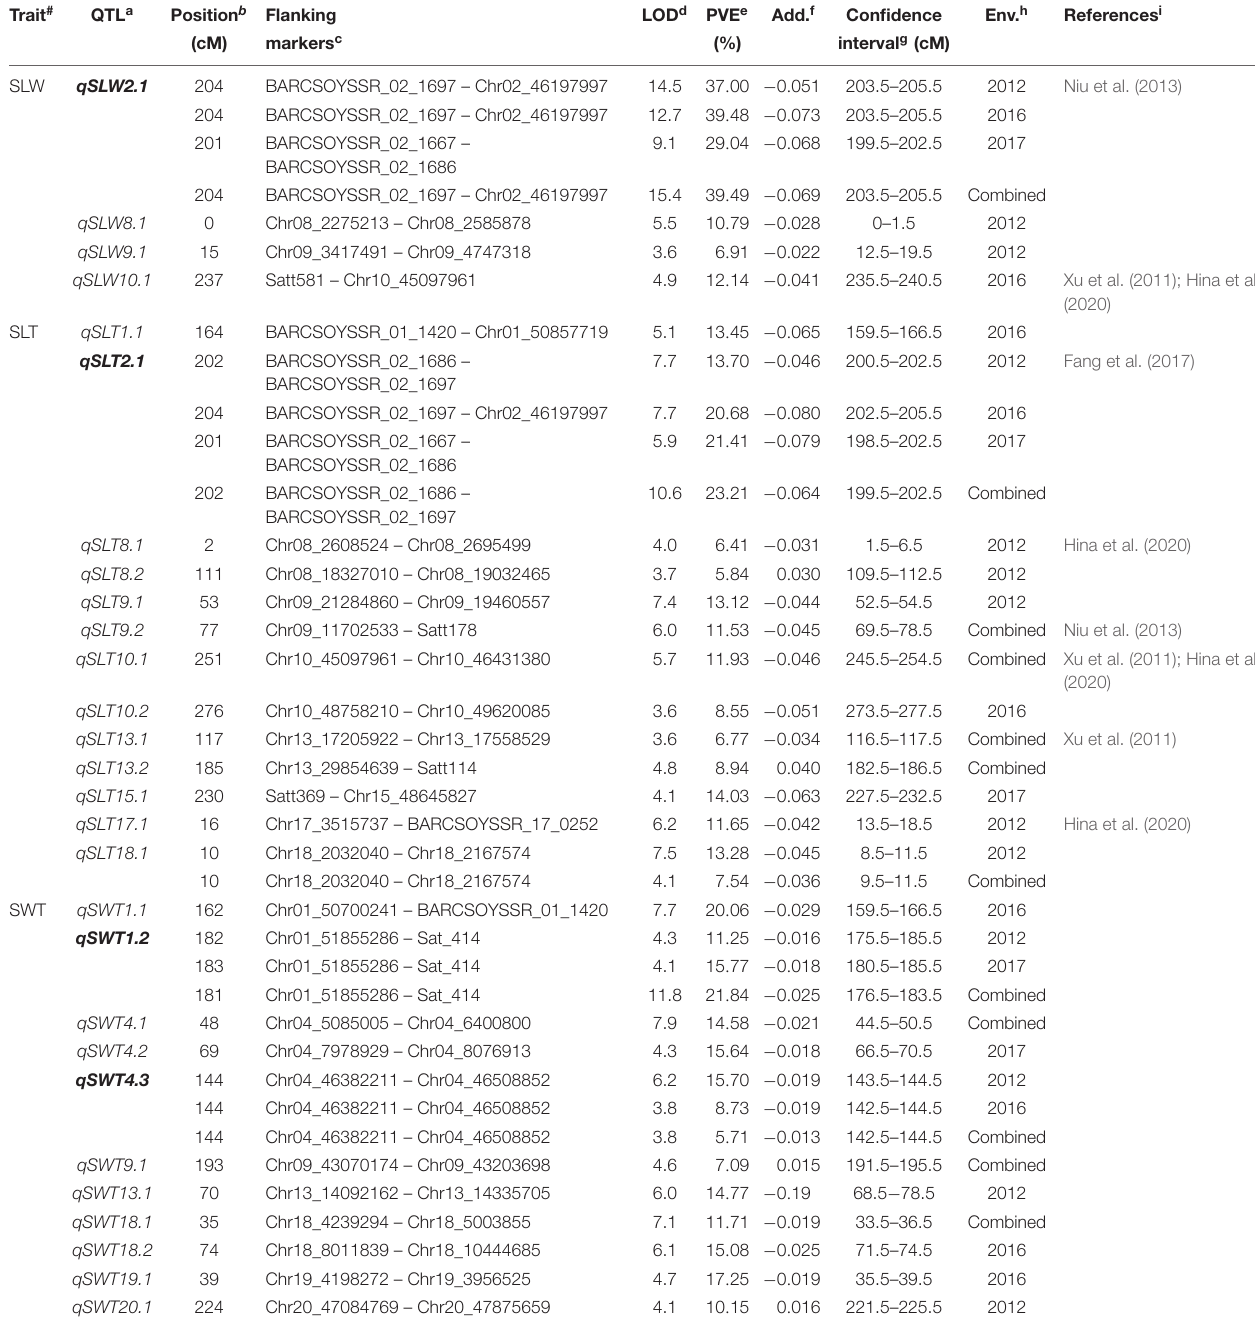
TABLE 2 | QTLs identified for seed-shape traits in K099 × Fendou 16 RIL population across multiple years. Trait